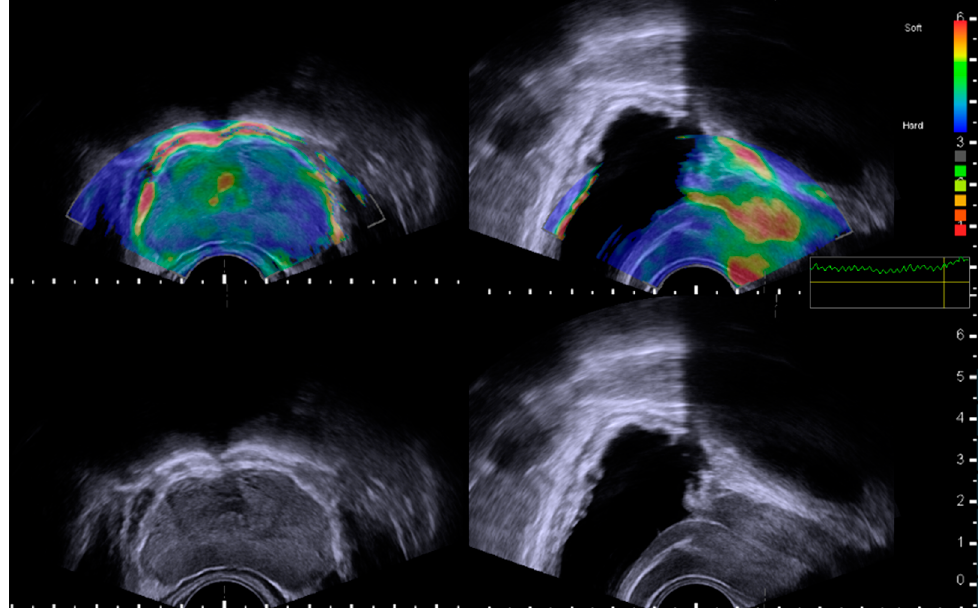
Figure 1. Measurement of prostate elastography. Elastogram-merged mapping images to the gray-scale images delineate elasticity scales with a color-coded image according to the continuous elasticity color scale (blue for the hardest area and red for the softest area). Elastography was performed on the largest transverse section (upper left) and the midsagittal plane including the entire urethral course of the prostate (upper right). Quality-scale monitoring was performed for each examination to ensure whether the elastography was performed correctly, with proper pressure and contact between the probe tip and the posterior aspect of the prostate, or not.